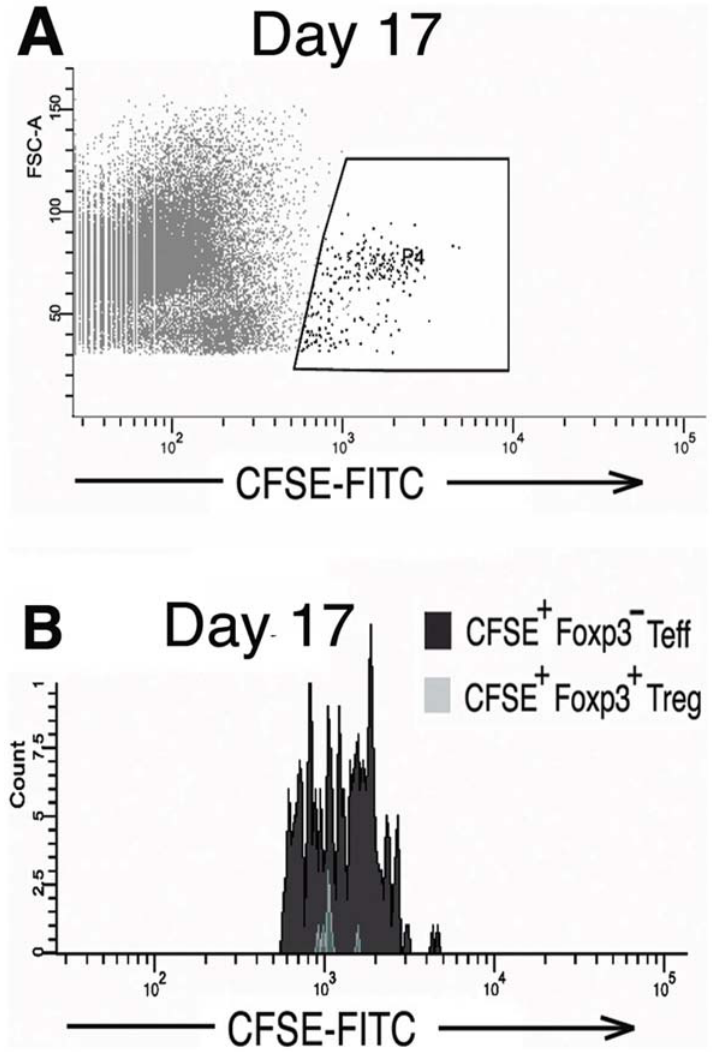
Figure 6. Persistent invivo survival and proliferation of CD4 + Foxp3 2 T effs when these cells are first expanded invitro under T reg depleted culture conditions (expanded, ‘‘unconditioned’’ T effs ). A) Survival and division of CFSE labeled, unconditioned CD4 + Foxp3 2 T effs could be detected up to 17 days following adoptive transfer at which time the FITC intensity of CFSE labeled cells approached the auto-fluorescent baseline. Dot plot at day 17 demonstrating the sorting gate for FITC-bright, CFSE + cells. B) Cells sorted from the gate in Panel A are . 98% Foxp3 2 consistent with the adoptively transferred T effs (characteristic findings from 3 mice).